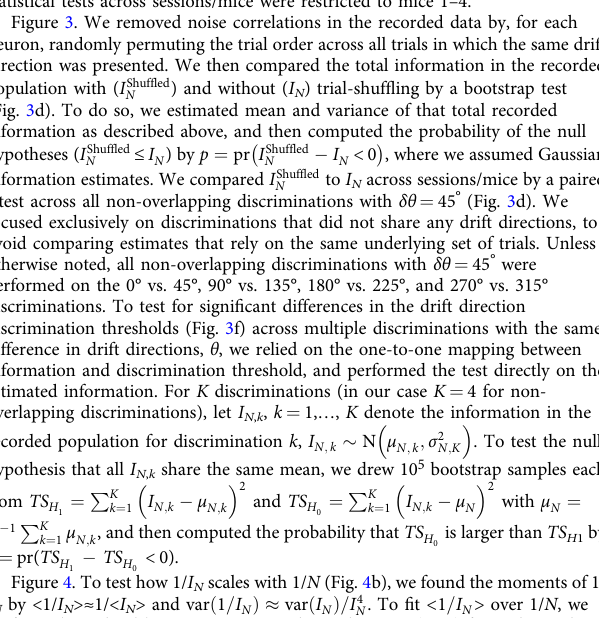
these correlations. Such a correction might lower the reported R 2 values. Therefore, the Bayesian model comparison across different information scaling models, as reported in the main text, provides a statistically sounder con fi rmation of limited asymptotic information. Figure 5. The shaded error regions in Fig. 5a relied on parametric bootstrap estimates. For information scaling for a fi xed ordering, we computed the estimate and variance of I 1 , I 2 , … by the Fisher information and the variance of this estimator (see SI), and used these estimates to compute mean and variance of the information increase associated with adding individual neurons to the population. We then re-sampled these information increases from Gaussian distributions with the found moments, and summed the individual samples to fi nd different samples for the whole information scaling curve. These samples were in turn used to estimate mean and variance of the information scaling for a fi xed order with which neurons were added to the population. This procedure was chosen, as the increase in Fisher information is independent across added neurons, whereas the total Fisher information is not. A similar procedure was used to fi nd the estimates for random orderings, for which we additionally shuf fl ed the order of neurons across different samples of the information scaling curve. The above procedures yielded 10 3 bootstrap samples for each information scaling curve, which we in turn used to fi nd samples for the population sizes required to capture 90% of the total information (Fig. 5a, b). In neither case did we apply bias correction of the Fisher information estimate. This bias correction would have been stronger for larger population sizes, which would have led to a seeming (but not real) drop of information with population size, resulting from a lower number of trials per neuron in the population, and an associated stronger bias correction. Figure 6. To identify for individual discriminations if increasing the stimulus contrast increased information in the recorded population (Fig. 6a, b), we estimated information in the recorded population by the bias-corrected Fisher information estimate 30 , and its variance by our analytical expression for this estimate ’ s variance (see SI). We assumed the estimate for low and high contrast, I LO N and I HI N , to be Gaussian, and found the probability of no information increase (cid:5) (cid:6) by pr I HI N ≤ I LO N , using the aforementioned moments. The paired t -test across sessions/mice (Fig. 6b) did not take into account the information estimates ’ variance. For Fig. 6e, higher contrast was considered to signi fi cantly increase the information in the recorded population ( fi lled dots in Fig. 6e), if it did so for at least fi ve out of eight possible discriminations with δθ = 45 ° . Figure 7. To test the relationship between c and I ∞ in Fig. 7d, we performed the linear regression log 10 ( c ) = β 0 + β 1 log 10 ( I ∞ ). The relationship between N 95 and I ∞ was found by substituting c ¼ 10 β 0 I β 1 1 into the expression for N 95 , resulting in